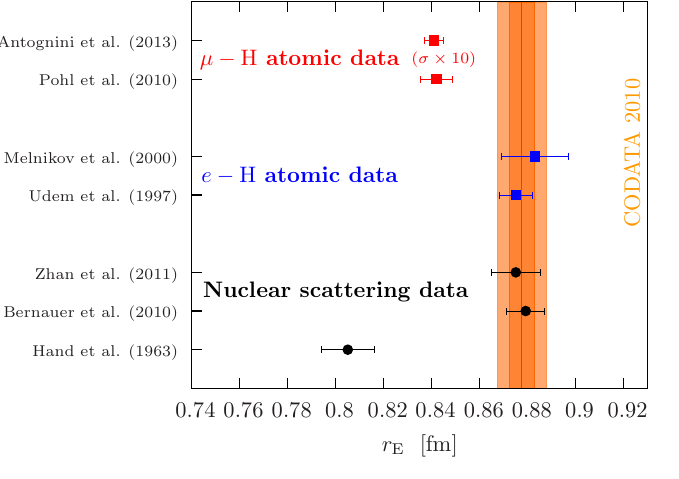
Figure 1. An overview of the best proton charge radius measurements. Full circles show findings of the scattering experiments. Full squares represent values obtained from the Lamb shift spectroscopy. The val- ues determined from the muonic hy- drogen measurements are colored red. The uncertainties of muonic hydrogen data are multiplied by fac- tor 10 for clarity